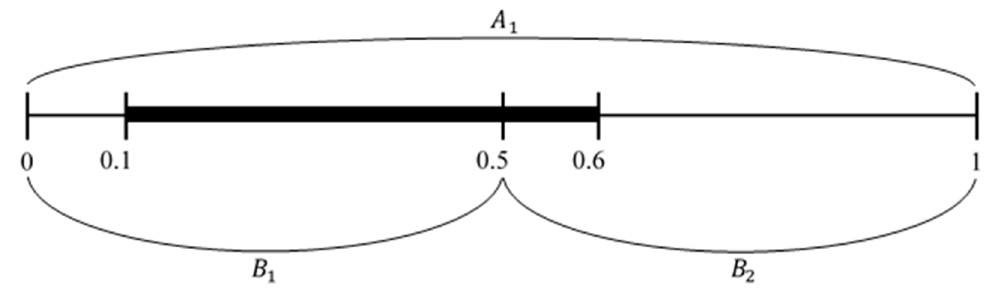
Figure 1. Information sets for simple example.